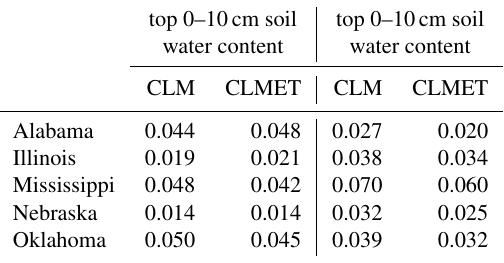
Table 5. Root mean square error (RMSE) values of monthly vol- umetric soil moisture (m − 3 m − 3 ) simulated by CLM and CLMET relative to the quality controlled NASMD for the top 0–10cm soil layer and for the top 0–100cm soil layer over Alabama, Illinois, Mississippi, Nebraska, and